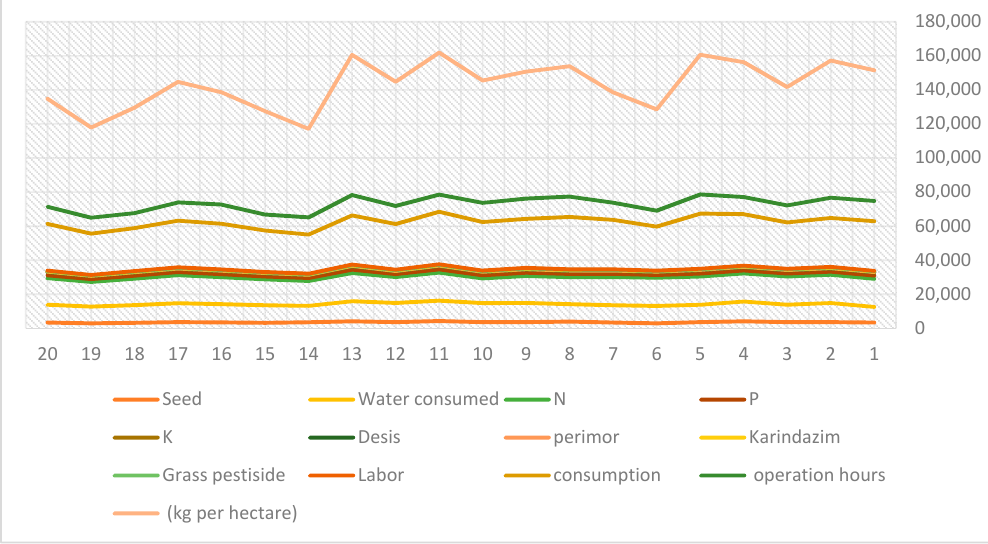
Figure 6. Input and output energy charts.